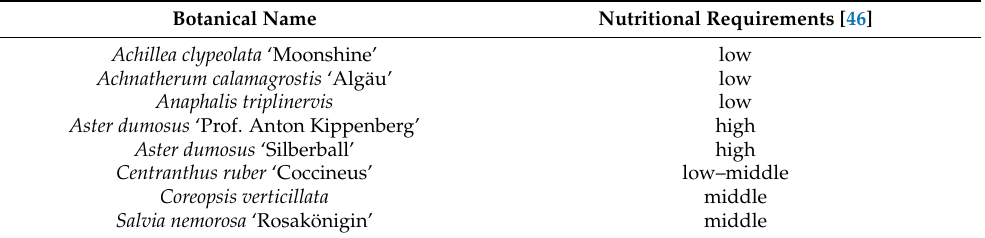
Table 2. Overview of the selected perennials for sunny positions and nutritional requirements. Botanical